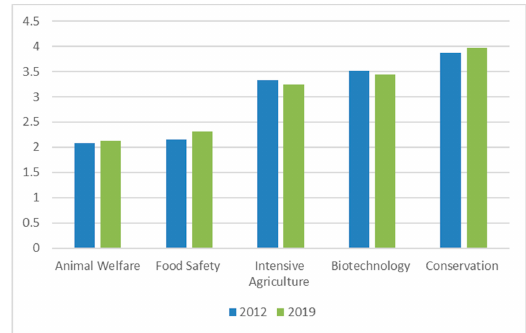
Figure 3. Ranking subjects (average value) according to importance in veterinary education (1—most important; 5—least important). When asked to choose between animal welfare and antimicrobial resistance as the most important topic, 51% choose the former and 49% the latter. Most respondents (60%; N = 34) stated that knowledge of AWSEL is viewed as a very important subject in their veterinary college, 37% (N = 21) answered that it is somewhat important, one respondent considered it not important and one